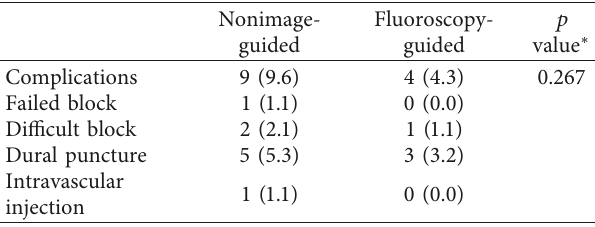
Table 4: Complications of blind and fluoroscopy-guided in- terlaminar epidural block in the same